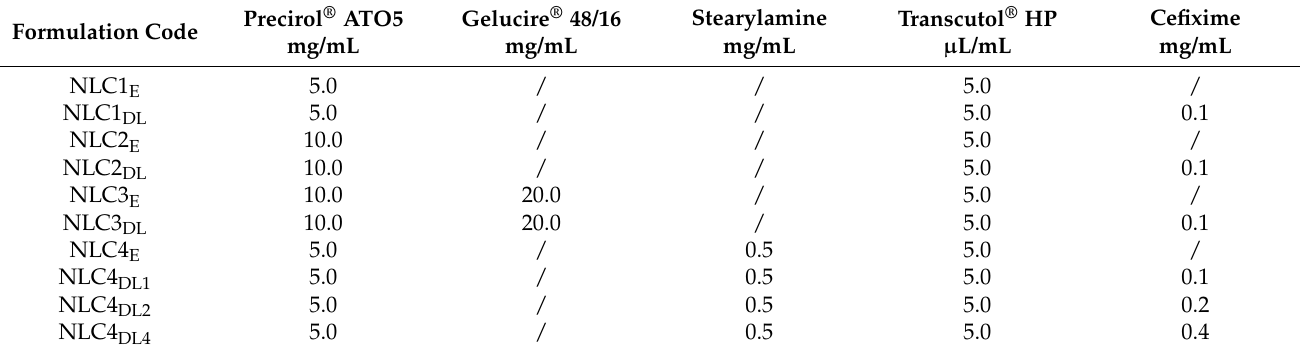
Table 2. Composition of the different NLCs formulations empty (E) or drug-loaded (DL).